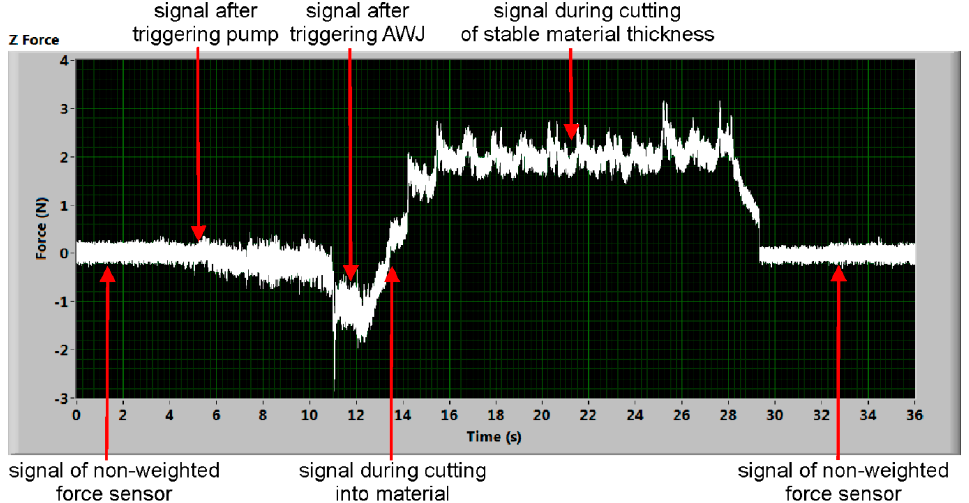
Figure 3. Shape of the typical measured signal in the z axis with description. Table 4. The ratio of the x and z forces (cutting and deformation) measured by force sensor with different traverse speed sets (bold signed values), the respective limit traverse speeds are in a separate column and the relative traverse speeds are presented in brackets [ ].